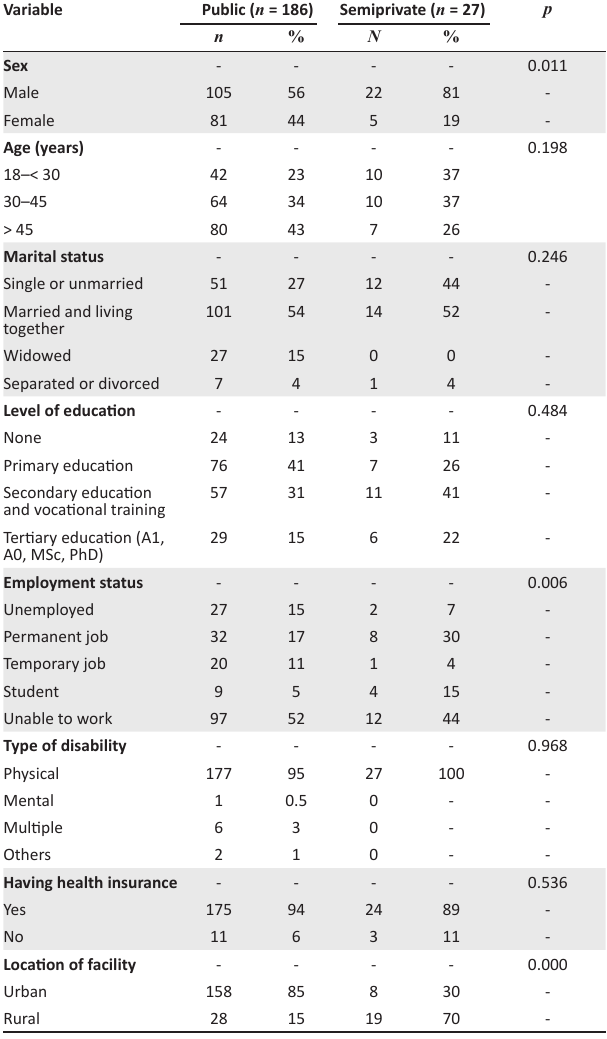
TABLE 3b: P -values for demographic characteristics by source of funding (public versus semiprivate) .